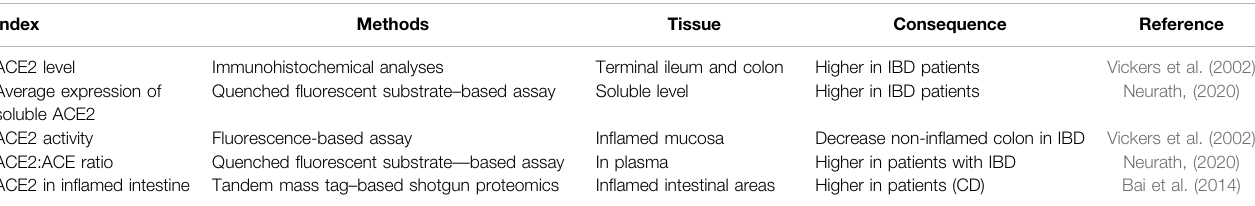
TABLE 1 | Comparison of ACE2 levels among different tissues in typical